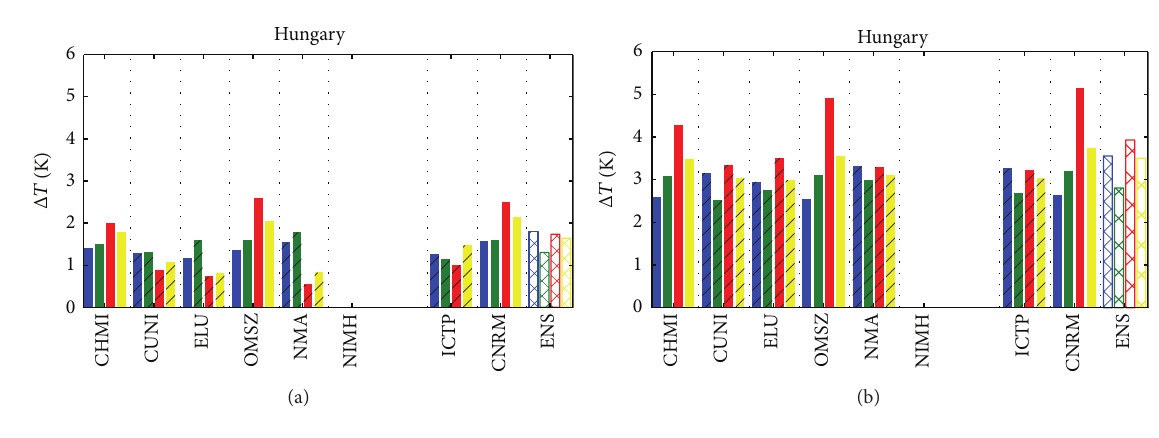
Figure 5: As Figure 3 for